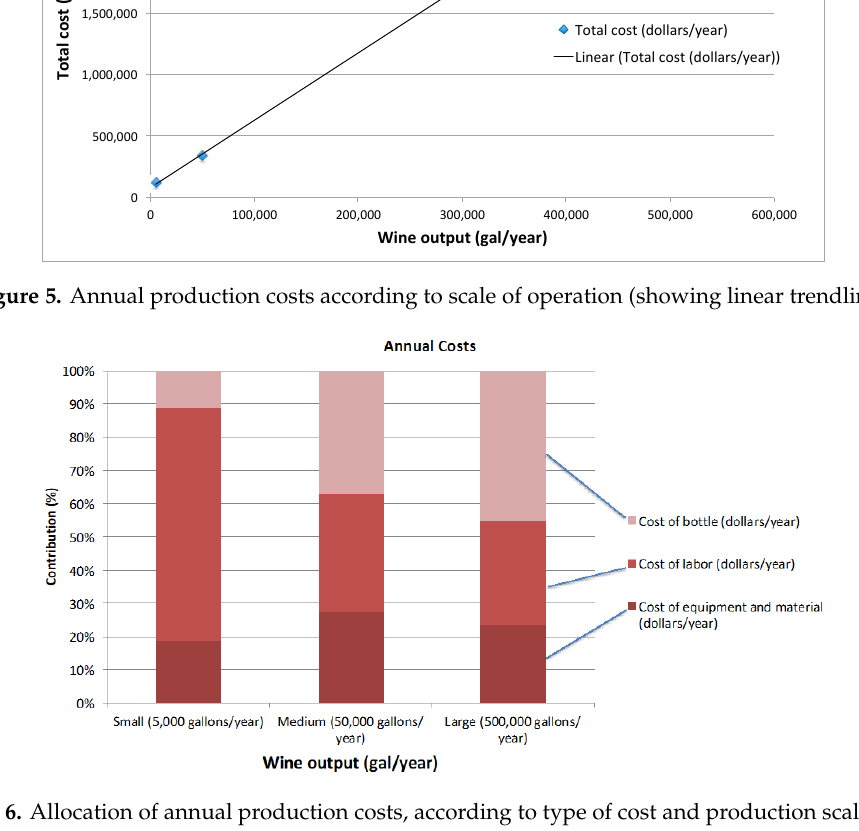
Figure 7. Annual revenues according to scale of operation. Figure 8. Annual revenues according to scale of operation (showing exponential trendline).